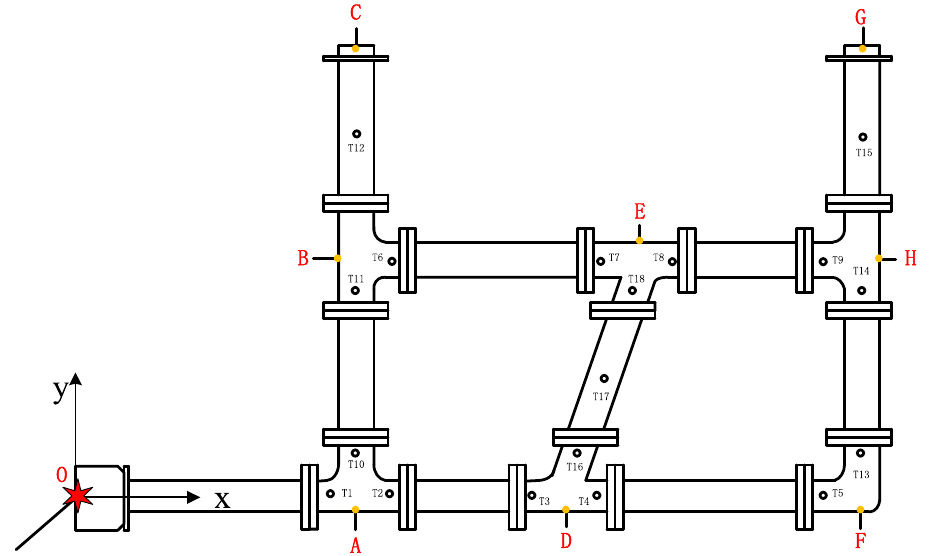
Figure 2. Transducer layout (Ti: flame and overpressure measured points).